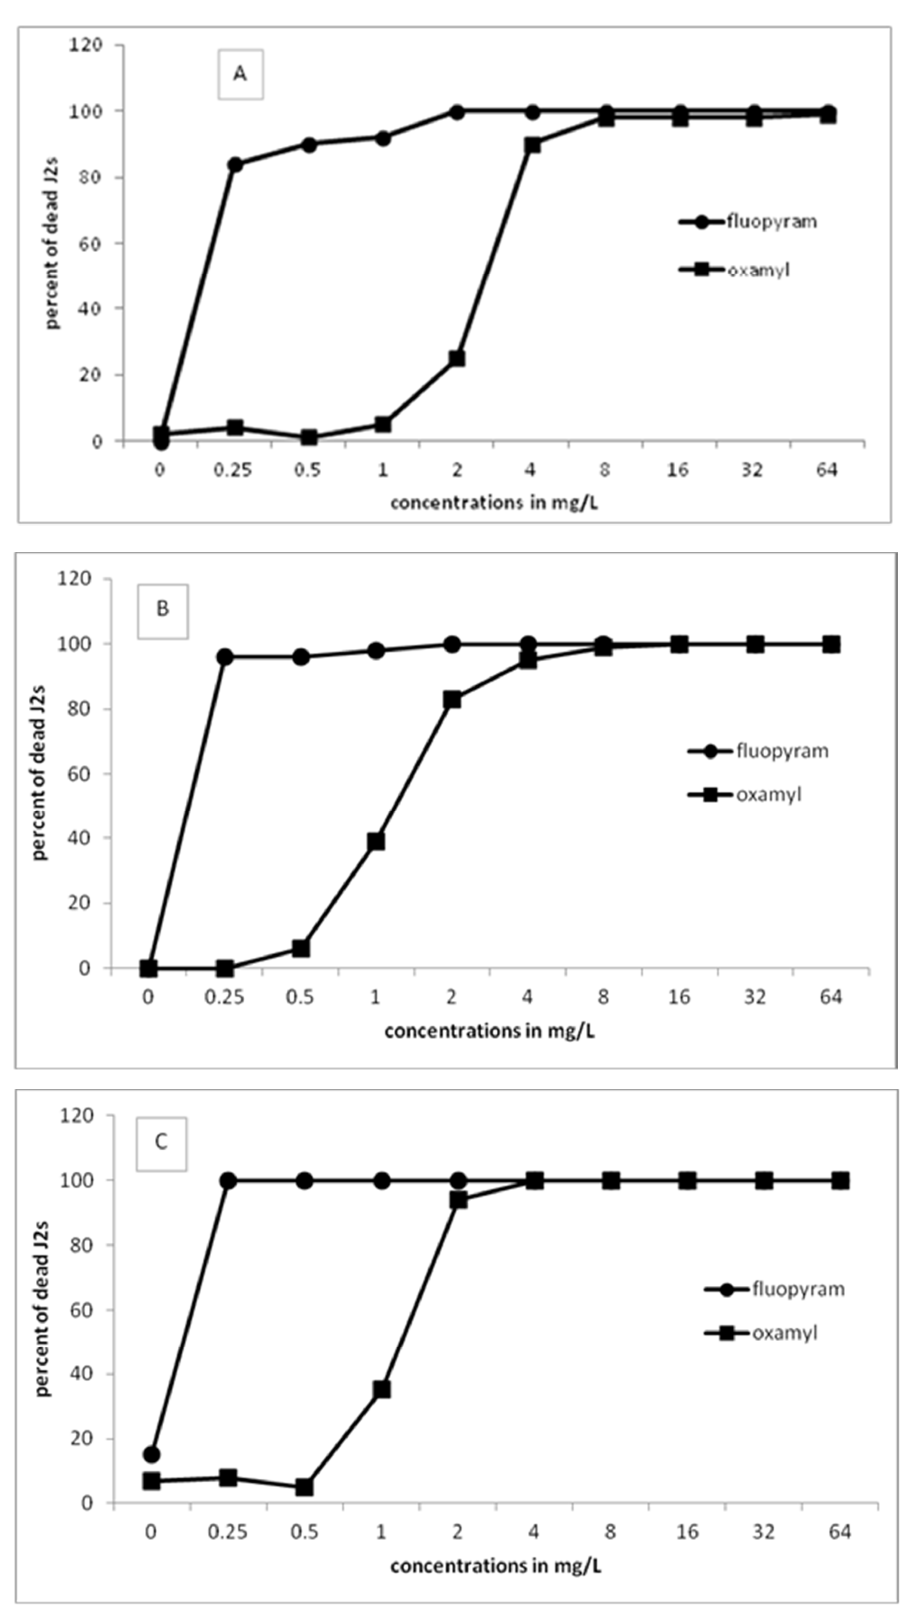
Figure 1. Effect of different concentrations of fluopyram or oxamyl on the motility of second-stage juveniles of Meloidogyne javanica after immersion of 50 J2s in test solutions for 24 ( A ), 48 ( B ), and 96 ( C ) hours. Values are means of five replicates.